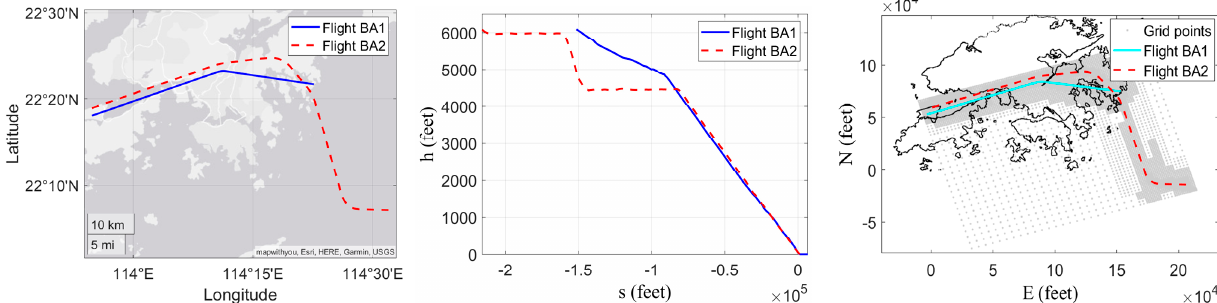
Figure 13. B777 aircraft approaching HKIA. Flights BA1 and BA2 respective routes (left: ground track, center: flight profile) and corresponding ground observers (dynamic grid, right).